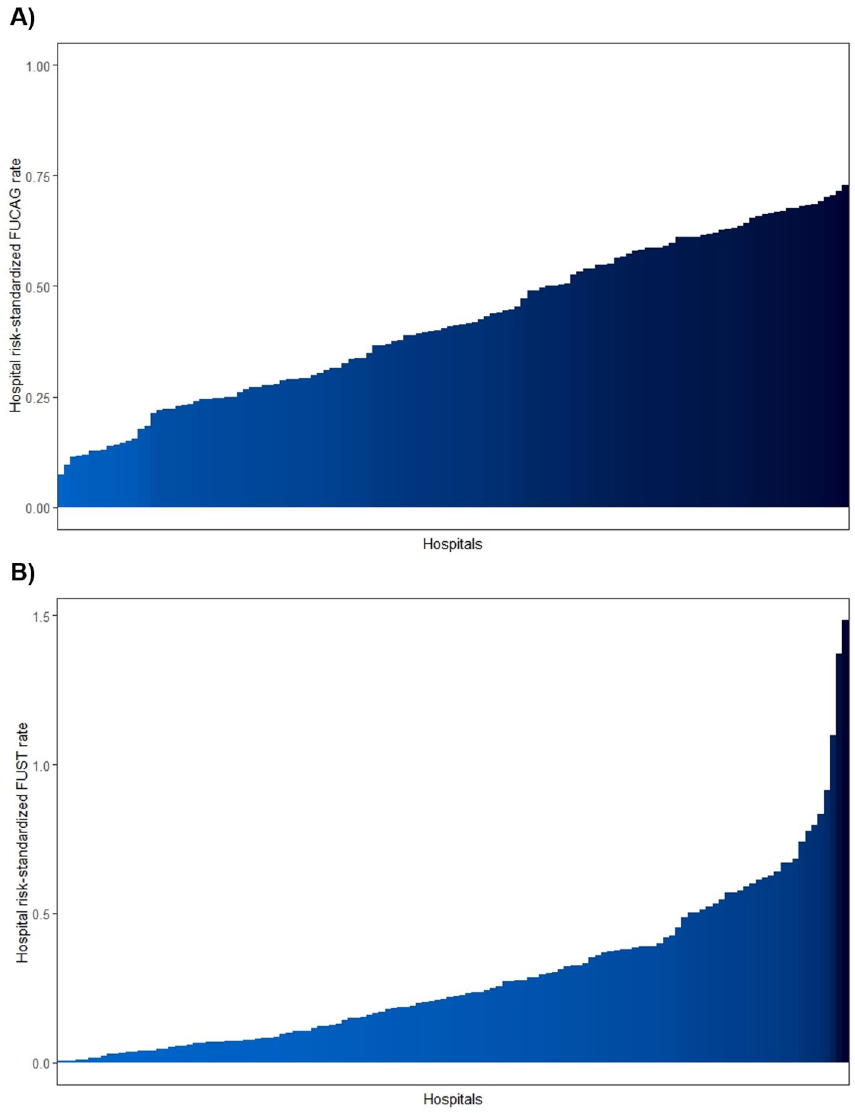
Figure 2. Risk-standardized rates of follow-up strategies after percutaneous coronary intervention across hospitals. ( A ) Graph showing hospital-level risk-standardized rates of FUCAG. ( B ) Graph showing hospital- level risk-standardized rates of FUST. FUCAG follow-up invasive coronary angiography, FUST follow-up stress testing. The figure was created with R (version 3.5.1) 4